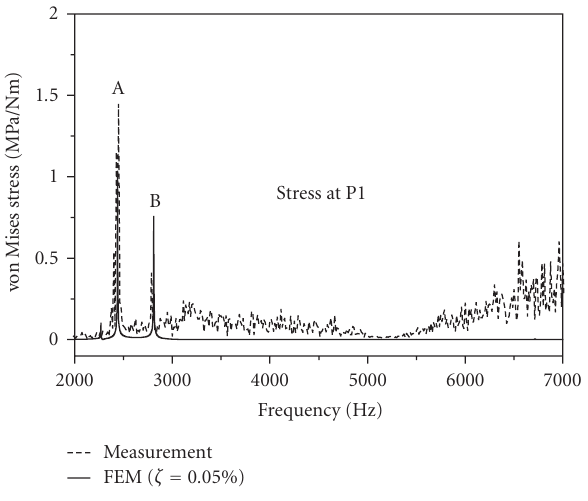
Figure 13: Blade stress at resonance versus natural frequency of mode 6 (FEM analysis) (see Table 1 and Figure 6 for mode